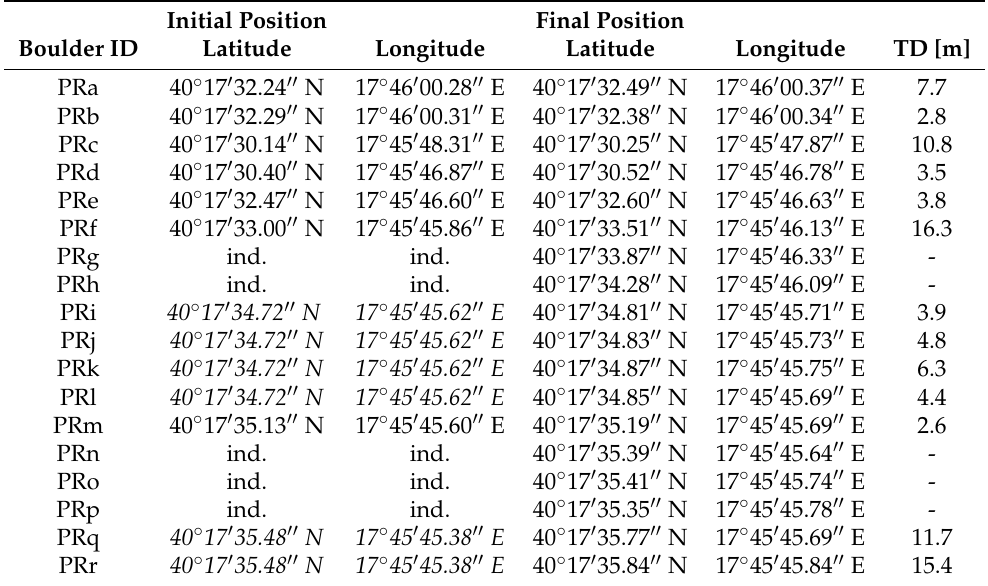
Table A1. Initial and final geographical coordinates of the displaced boulders at Punta Prosciutto headland; ind., indeterminable.